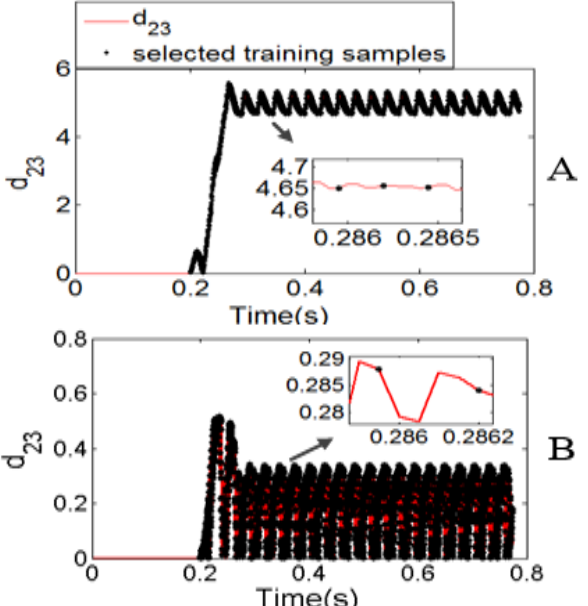
Figure 10. Training samples: ( A ) in a faulty mode, ( B ) in a healthy mode.